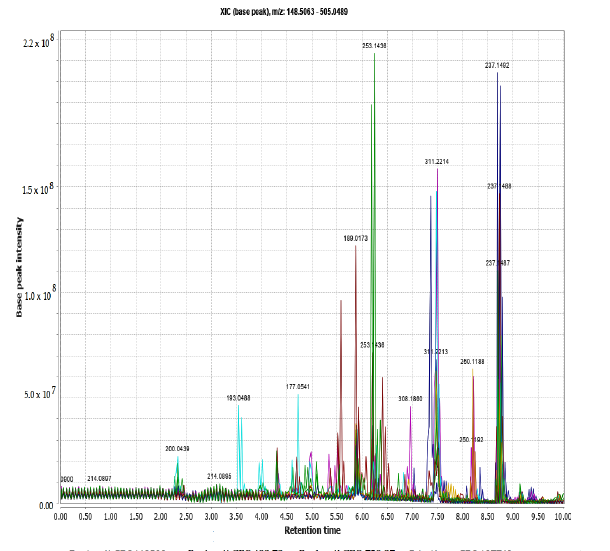
Figure 2. ( a ) Total Ions Chromatograms (TICs) of organic extracts of Phaeoacremonium spp. and culture media at UpHs; ( b ) (TICs) of organic extracts of Phaeoacremonium spp. and culture media at pH 2. Table 4. Identification and quantification of scytalone ( 1 ) and isosclerone ( 2 ) by LC-MS/MS analysis.